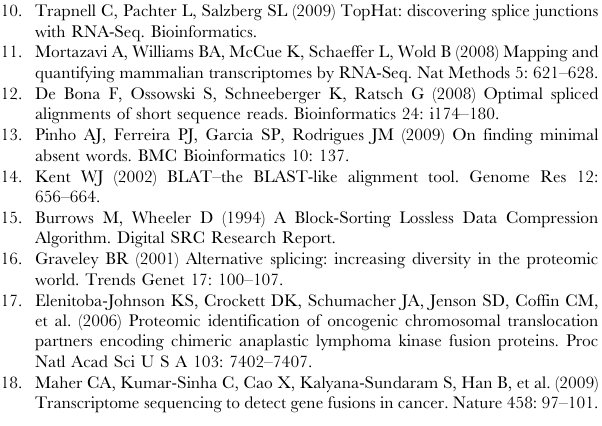
Figure S1 The construction of decoy splicing events by exchange the prefix and suffix of the corresponding exons in real exon models (i). MAW matched to sequences in decoy exon models (ii) would equal to MAWs matched to a very rare, if at least possible, splicing event in real exon models (iii). Figure S2 The number of minimal absent words from genome sequence of different length. Results were based on mm9 genome sequences. Figure S3 UCSC snapshot of splicing events identified by SAW from multiple reads in gene Gpbp1L1. The splicing events (annotated by black reads) were not identified by ERANGE based